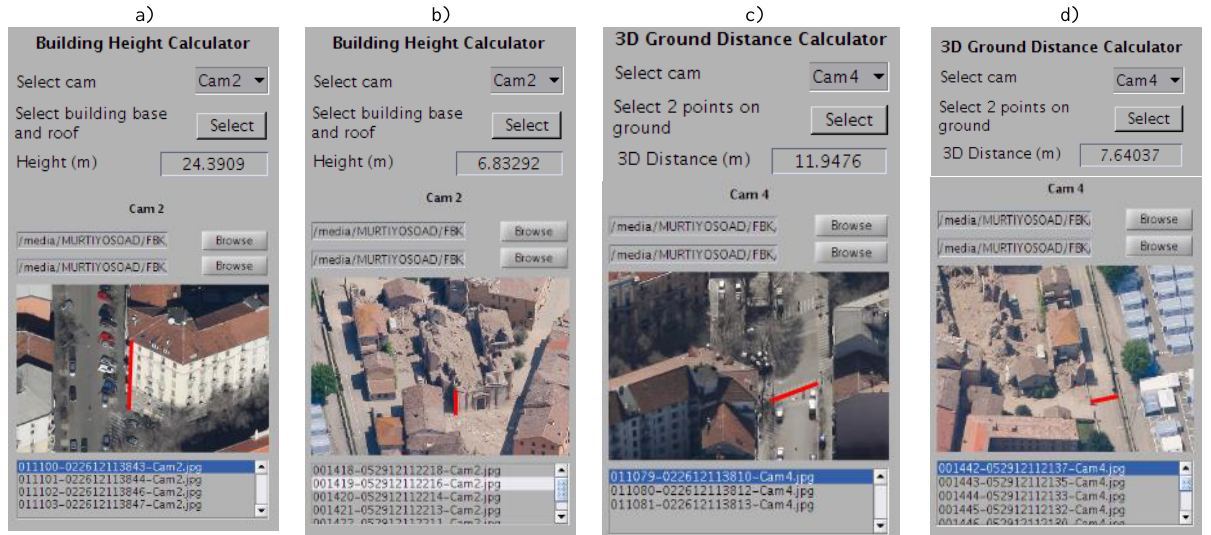
Figure 4: Use of the monoplotting tool to derive building heights (a, b) and measure ground distances like street’s width (c, d) in urban and natural hazard scenarios.